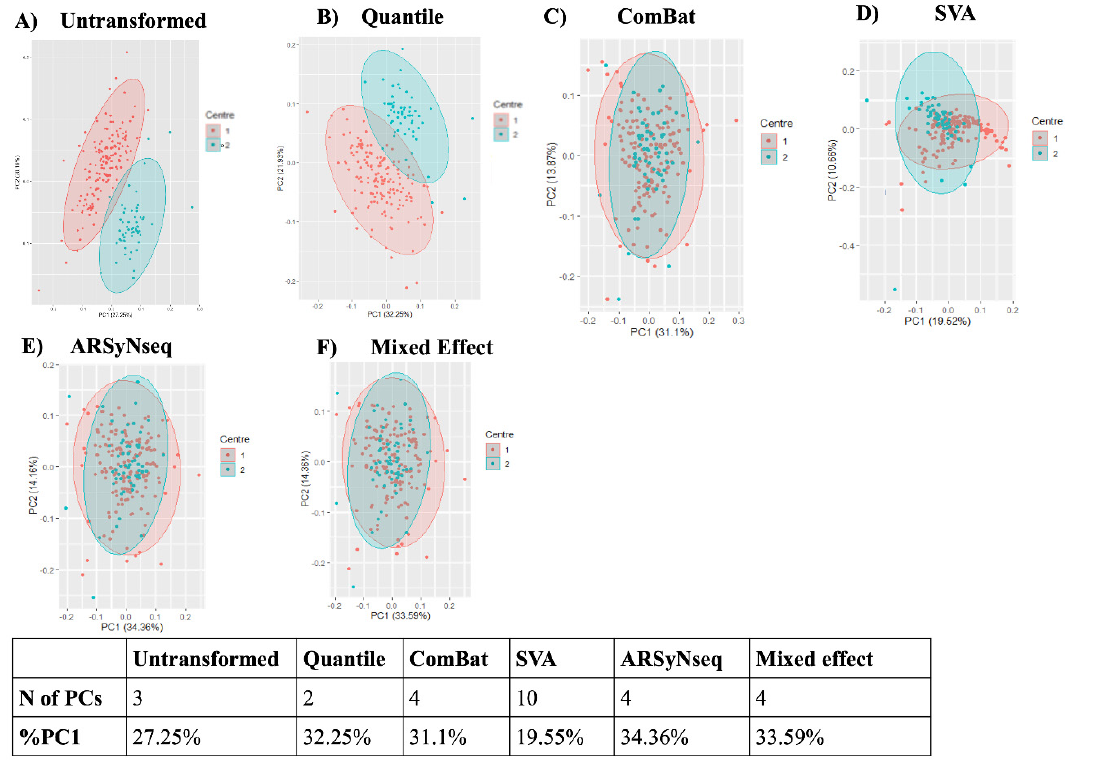
Figure 3. PCA scatter plots and summary table of N of PCs and percentage of variance explained by PC1 (%PC1). ( A ) Untransformed scaled; ( B ) quantile; ( C ) ComBat; ( D ) SVA; ( E ) ARSyNseq; and ( F ) mixed effect model.